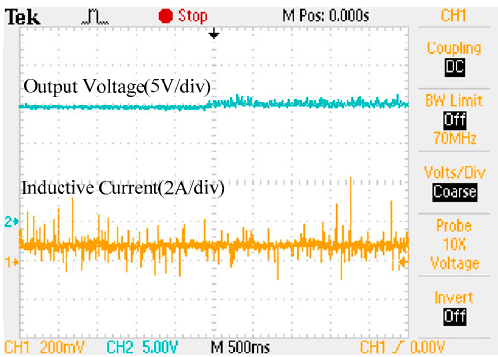
Figure 21. Experimental step ‐ input ‐ voltage waveforms of the output voltage and inductive current under the TSM + DOB controller.